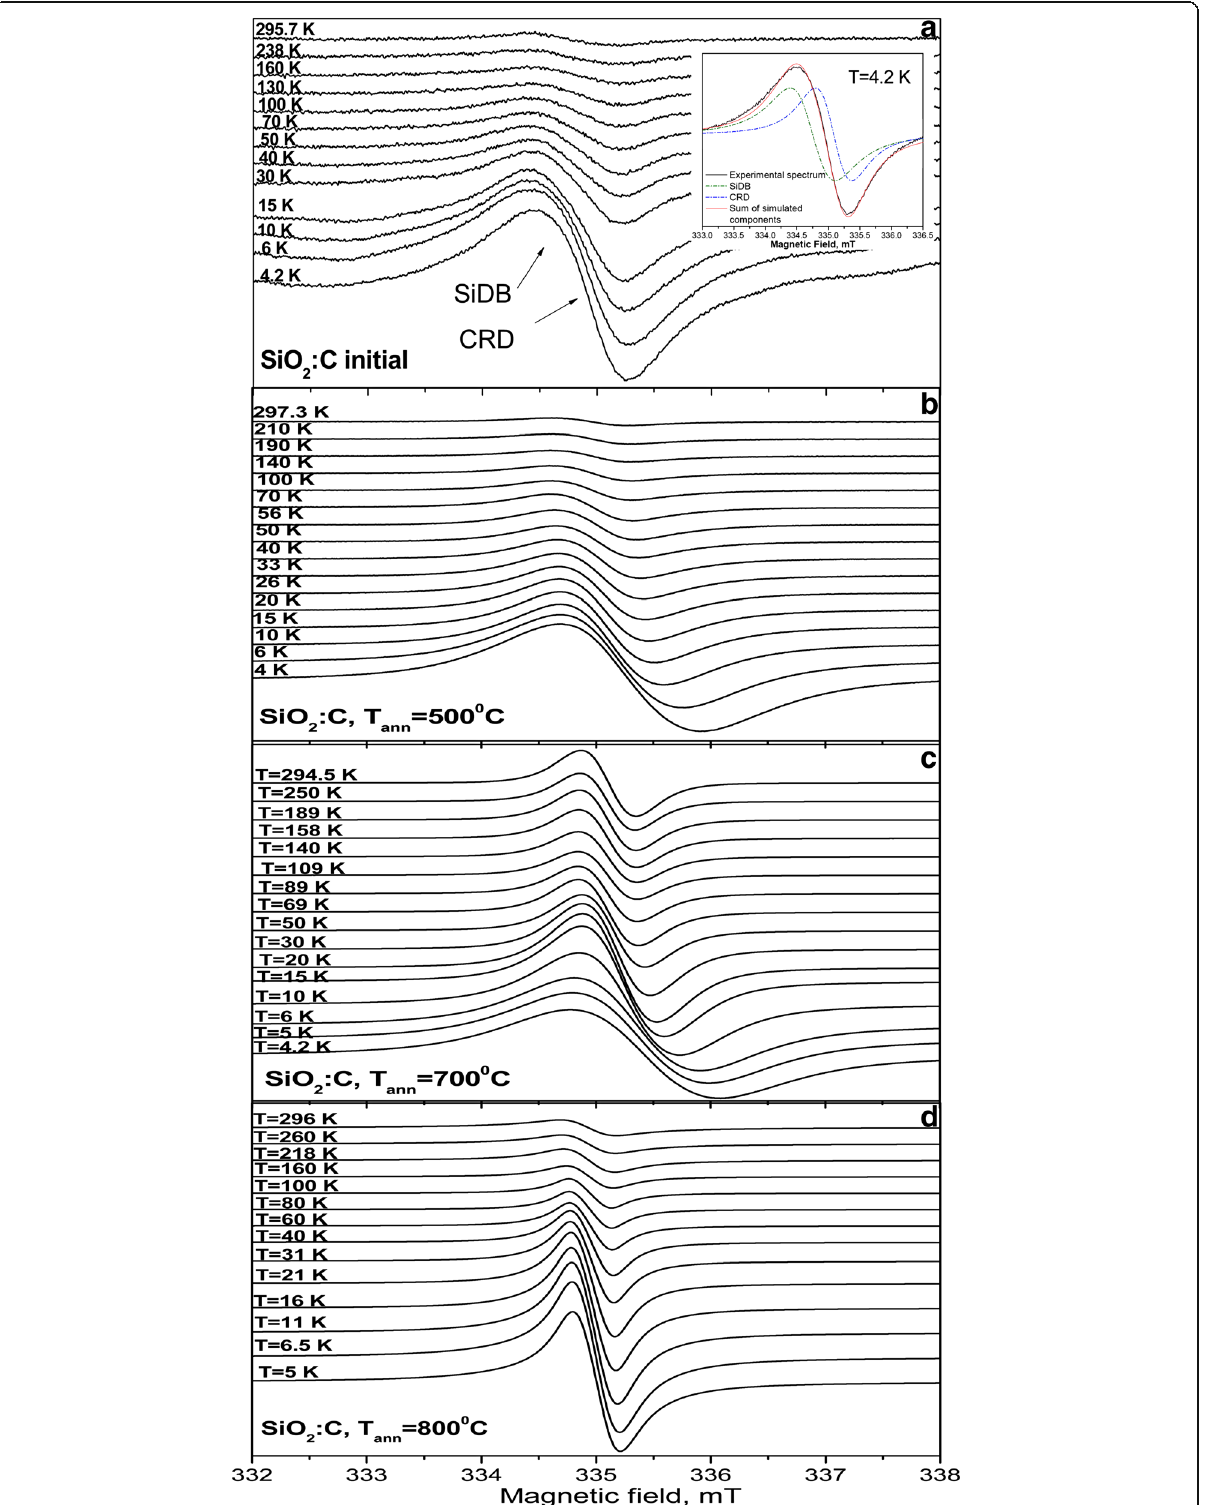
Fig. 4 The temperature behavior of X-band CW EPR spectra measured in initial SiO 2 :C ( a ) and SiO 2 :C samples annealed at 500 °C ( b ), 700 °C ( c ), and 800 °C ( d